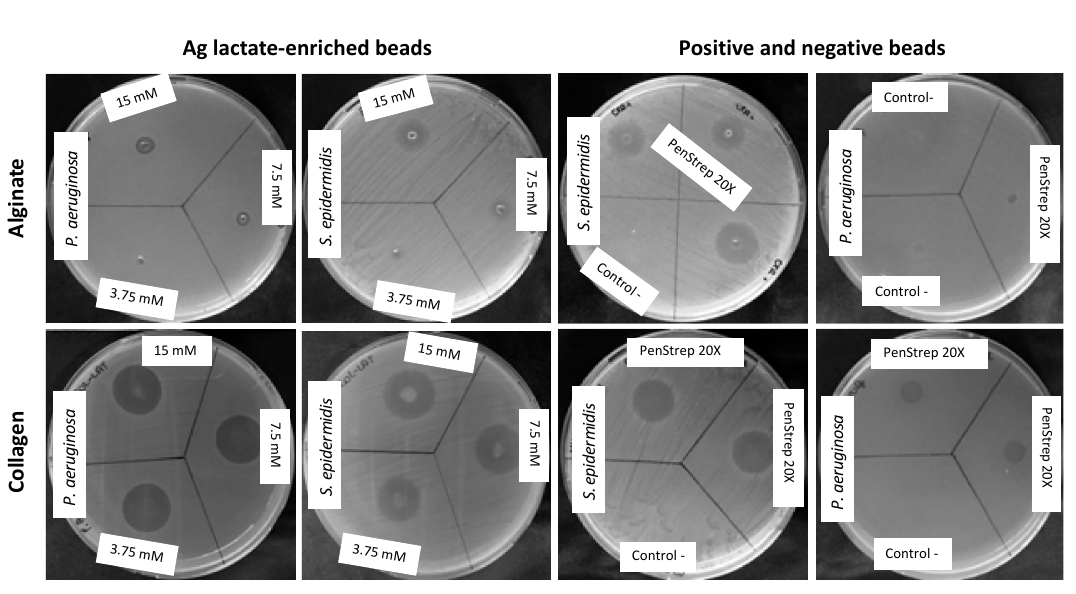
Figure 2. Representative images of biomaterials antibacterial activity. Alginate/collagen beads embedded with silver were placed on inoculated agar plates and incubated at 37 °C for 20 h. As positive control, beads were enriched with PenStrep 20×. Negative controls were also included to verify the inefficacy of collagen and alginate scaffolds only.